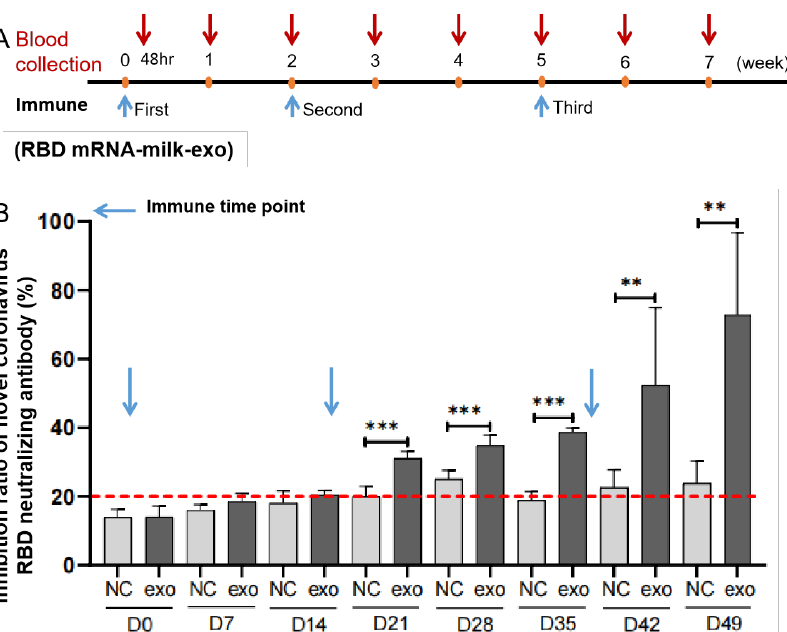
Figure 6. Validation of SARS-CoV-2 RBD mRNA-loaded milk exosomes delivering functional SARS-CoV-2 RBD mRNA in vivo. ( A ) Mouse immunization and sera sampling schedule. BALB/c mice received the same doses of an oral vaccine for the SARS-CoV-2—based milk-derived exosomes (N = 5) or the control saline (N = 3) on day 0 and were boosted again on days 14 and 35. Sera were collected on days 0 (pre-vaccination), 7, 14, 21, 28, 35, 42, and 49 (post-vaccination). The blue and red arrows represent the time points of immunization and blood collection, respectively. ( B ) Preliminary assessments for neutralizing antibodies of the oral vaccine for SARS-CoV-2—based milk-derived exosomes in serum were determined via ELISA. The red dotted line represents the cutoff value of neutralizing antibodies against the RBD peptide. N = 3 (control), and N = 5 (RBD-DC-milk-exos), and the data are presented as mean ± STD. ** p < 0.01, *** p < 0.001 vs. control group.